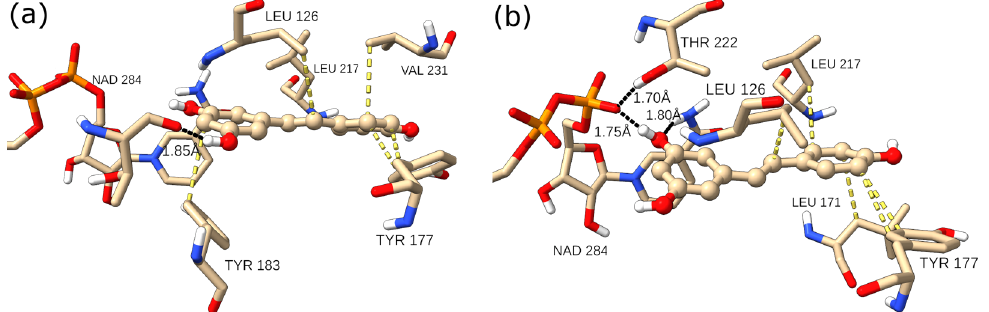
Figure 6. RES (ball and stick) in the catalytic pocket of 11 β -HSD-1 for conformations ( a ) (left) and ( b ) (right) with key intermolecular interactions. Black lines indicate hydrogen bonds, while yellow lines are hydrophobic interactions.